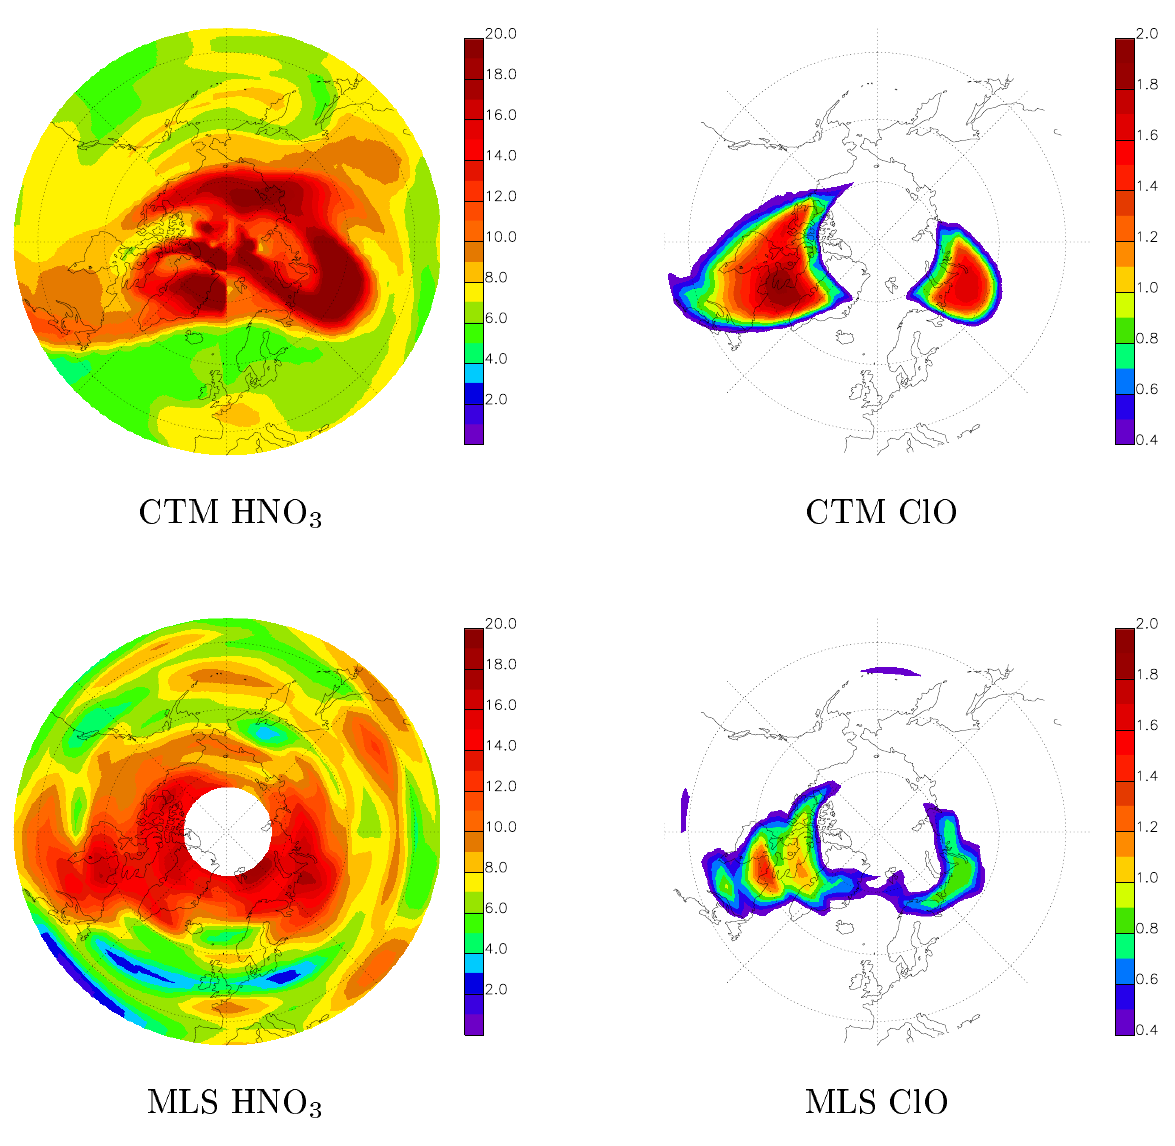
Fig. 2. False color maps of HNO 3 (left column) and ClO (right column) mixing ratio at about 45hPa, on 31 January 1997, from UARS/MLS data (bottom row) and as modelled with STRATAQ CTM (top row). Values are in ppbv. Only data for the dayside of the orbit are shown for MLS, while CTM data are plotted at local